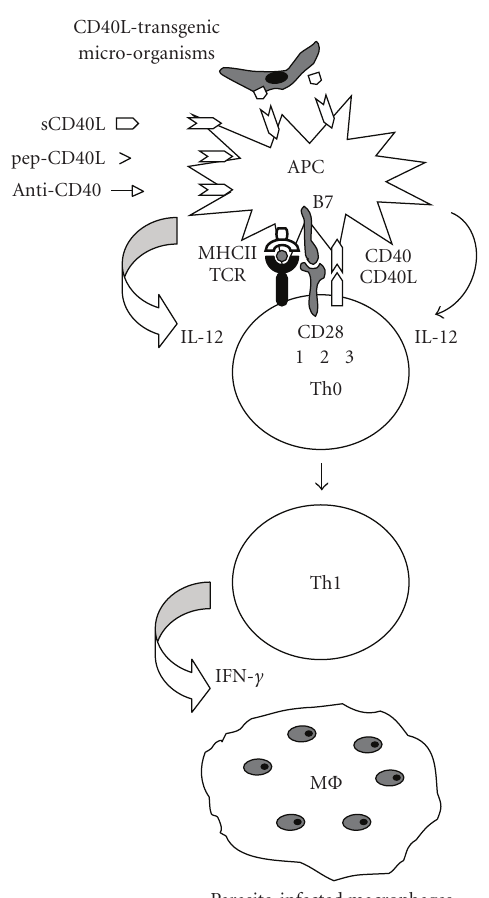
Figure 1: Schematical representation of enhanced cell-mediated im- munity against protozoan parasites through CD40-CD40L interac- tion . Following the first signal (1) illustrated by the recognition of parasite peptides combined with major histocompatibility com- plex II (MHC II) on antigen presenting cells (APC), such as den- dritic cells, by T cell receptor (TCR) on na¨ıve T helper cells (Th0), and the second signal (2) which is attributed mainly to binding of CD28/B7 molecule pairs, interaction of CD40-CD40L (3) activates APC to produce IL-12 which promotes Th1 cell di ff erentiation and secretion of IFN- γ . This leads to stimulation of macrophages to control parasite replication. This activation process can be ampli- fied by agonistic anti-CD40 antiboy, by soluble CD40L (sCD40L) or by CD40L peptide mimetics (pep-CD40L). Transgenic para- sites expressing CD40L can also activate CD40 signalling through membrane-bound or secreted